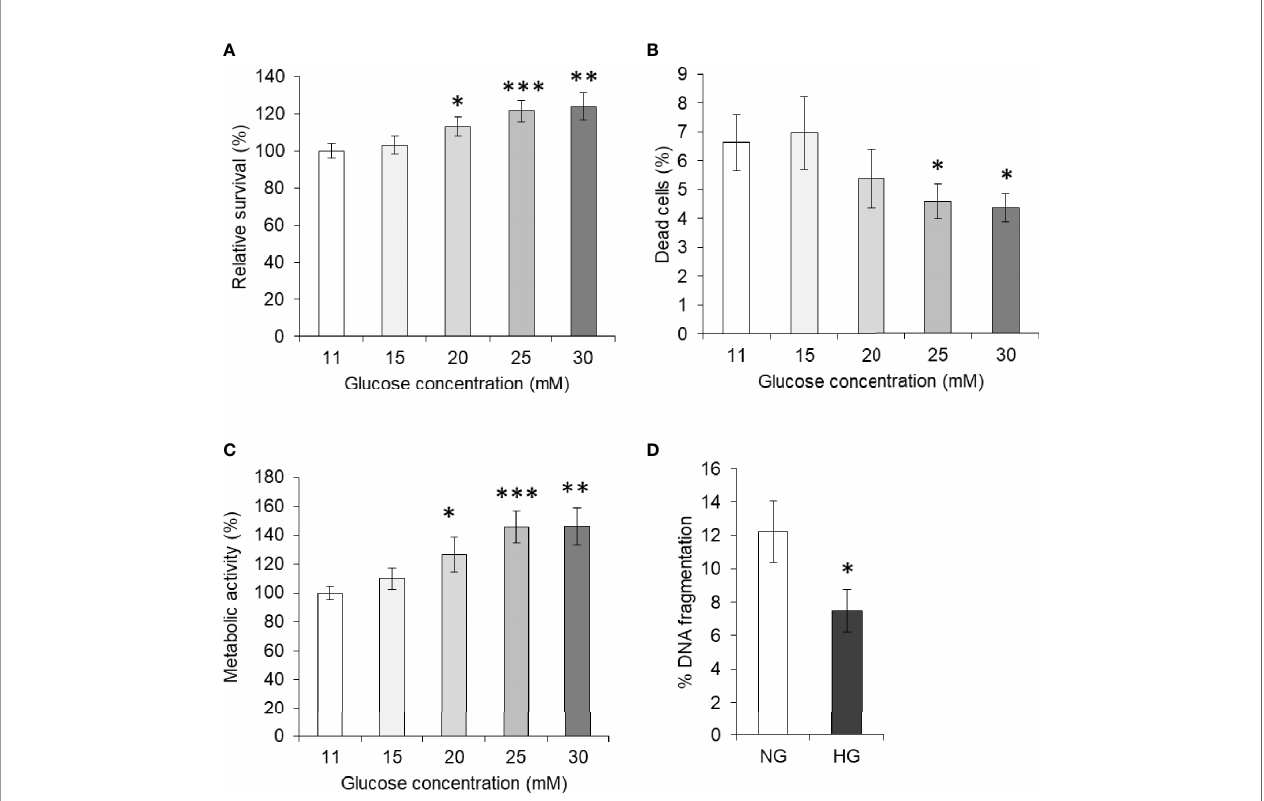
FIGURE 1 | High glucose enhances cell survival. Survival of HepG2 cells incubated in medium containing standard (11 mM) or higher concentration of glucose was estimated (A) . Cells were also enumerated for live and dead cell population, and dead cell percentage was calculated (B) . Metabolic activity of cells incubated in medium containing increasing concentration of glucose was estimated using MTT assay (C) . DNA fragmentation of cells incubated in medium with normal glucose (NG) (11 mM) or High glucose (HG) (25 mM) was determined (D) . The values shown are Mean ± SD of three independent experiments conducted in triplicate. * p < 0.05, ** p < 0.01, *** p < 0.001 vs values of cells incubated in medium with NG (11